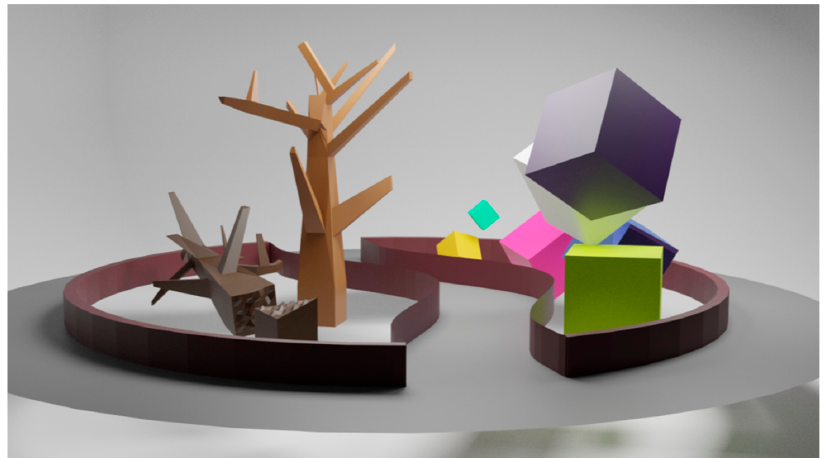
Int. J. Environ. Res. Public Health 2022 , 19 , x FOR PEER REVIEW Figure 5. Room no. 2 designed for a scope of aerobic activities. Figure 5. Room no. 2 designed for a scope of aerobic activities.